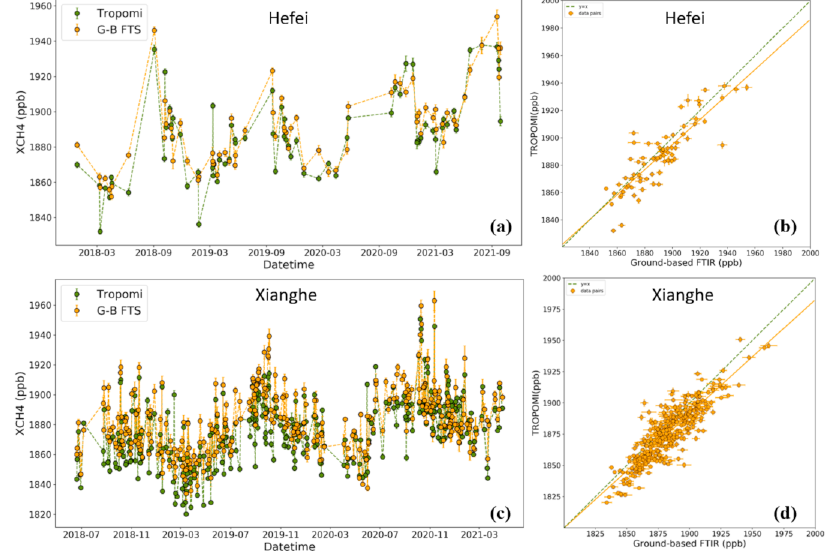
Figure 2. ( a ) Daily mean time series of dry-air column mixing ratios of CH 4 (XCH 4 ) observed by the TROPOMI (green points) and the g-b FTIR at Hefei site (yellow points). ( b ) Correlation scatter diagram between the TROPOMI and the FTIR data over Hefei based on ( a ). The slope of the regression line without intercept is 0.93. ( c ) Daily mean time series of dry-air column mixing ratios of CH 4 (XCH 4 ) observed by the TROPOMI (green points) and the g-b FTIR at Xianghe site (yellow points). ( d ) Correlation scatter diagram between the TROPOMI and the FTIR data over Xianghe based on ( c ). The slope of the regression line without intercept is 0.95. The average for FTIR products was only performed from 11:00 to 15:00 local time (LT), that is within ± 2 h of TROPOMI overpass time (about 13:00 LT). Vertical error bars for TROPOMI and FTIR represent diurnal variabilities of the respective